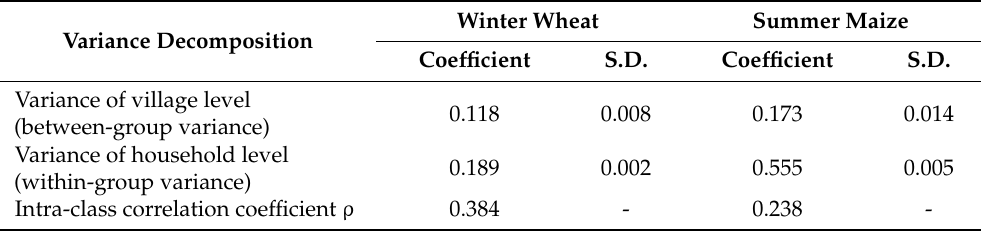
Table 5. The estimated results of unconditional means model.